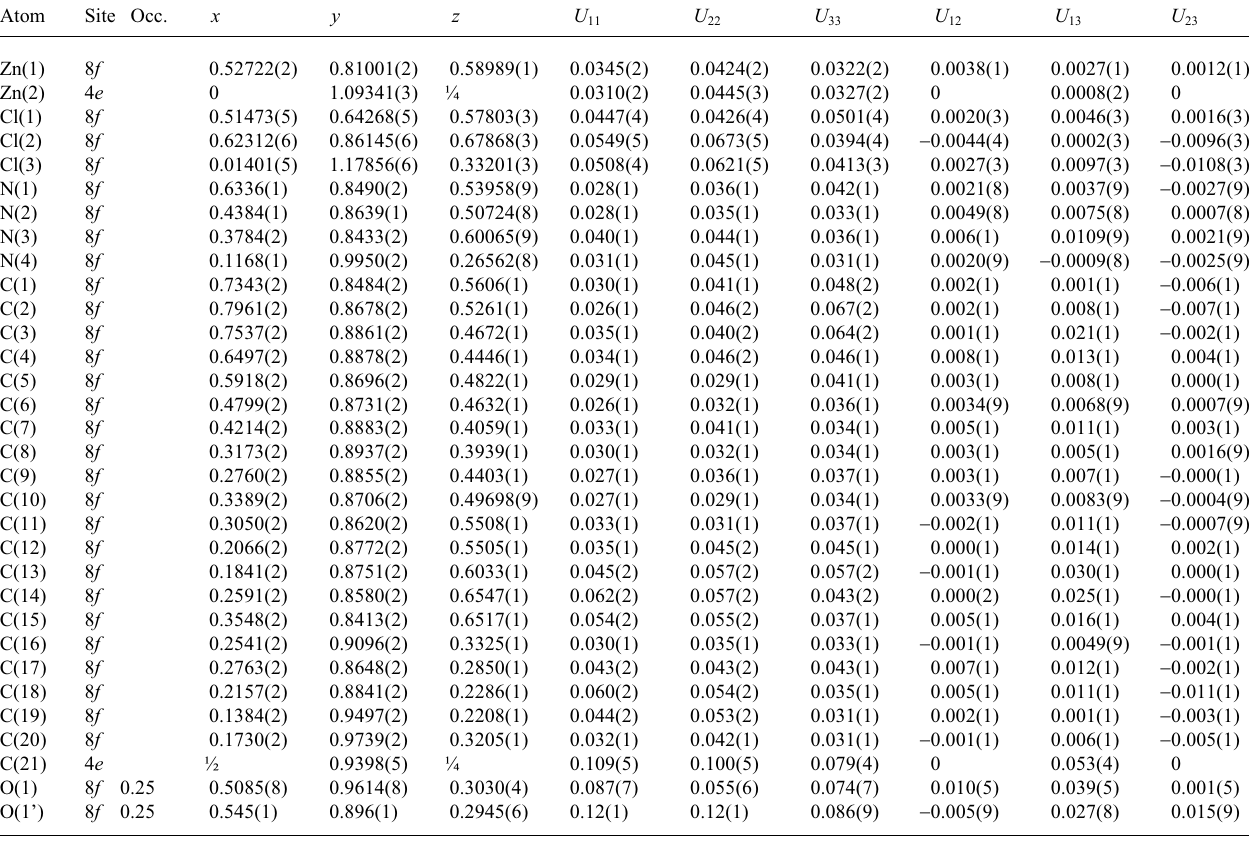
Table 3. Atomic coordinates and displacement parameters (in Å 2 ) . Atom Site